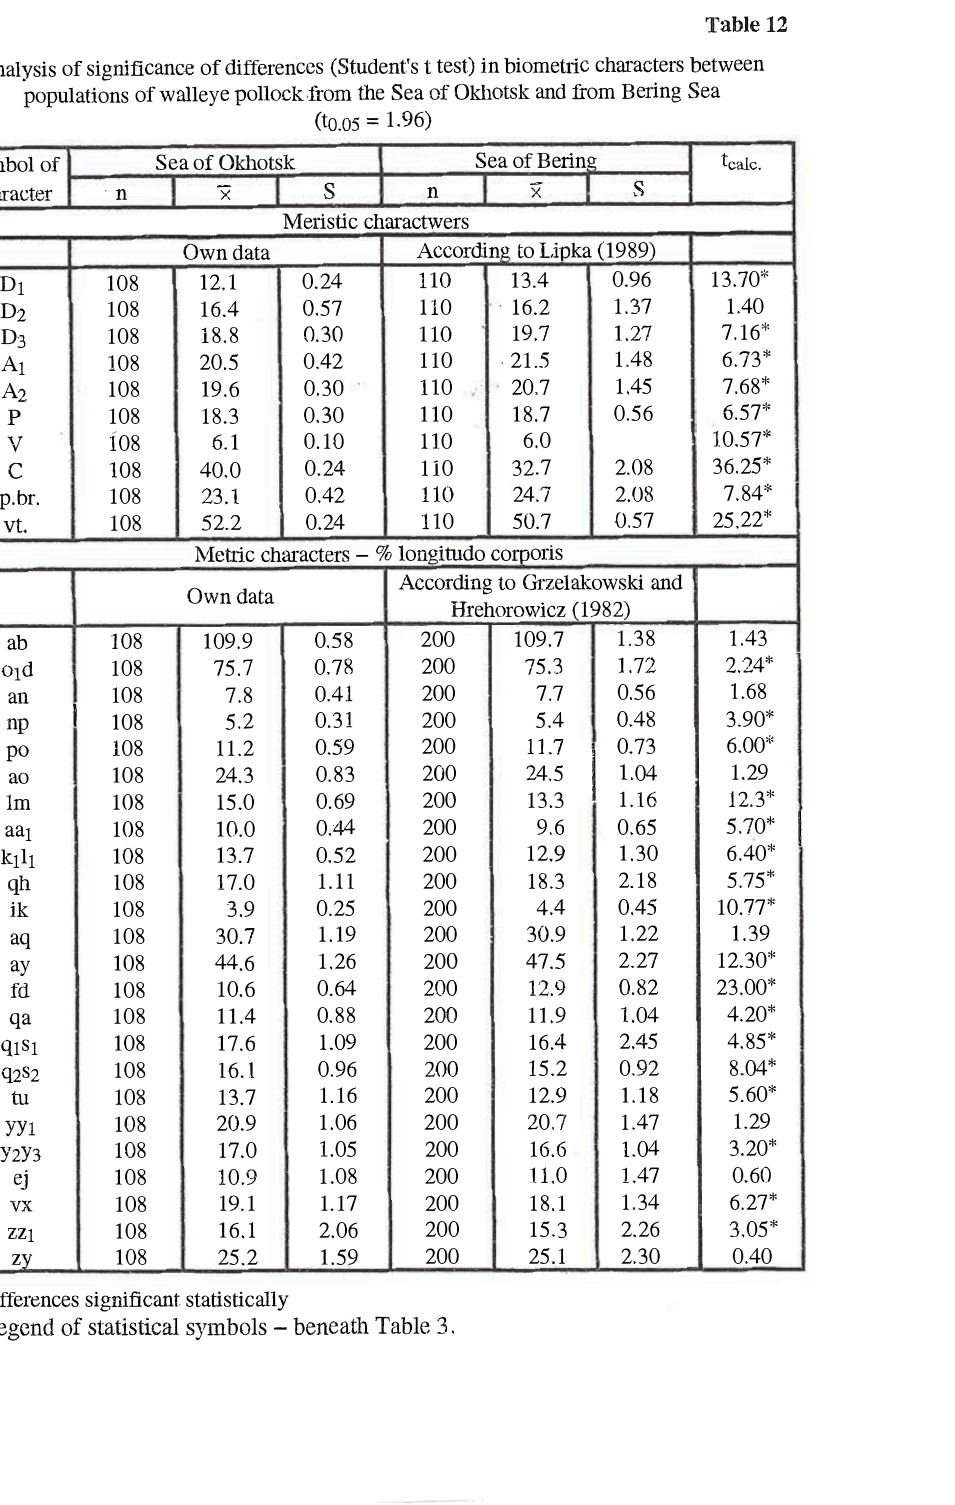
Analysis of significance of differences (Student's t test) in biometlic populations of walleye pollack from the Sea of Okhotsk and from Beling Sea (to.OS = 1.96) Symbol of Sea of Okhotsk Sea of Beling